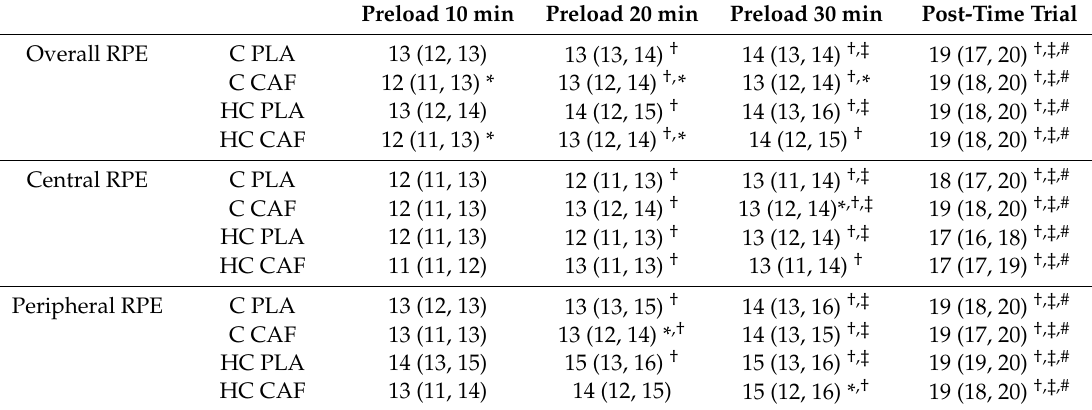
Table 1. Overall, central and peripheral ratings of perceived exertion (RPE) at 10, 20 and 30 min during the preload and immediately post-time